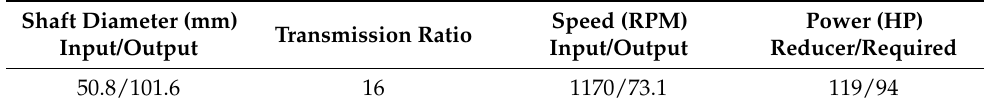
Table 1. Operational parameters of the speed